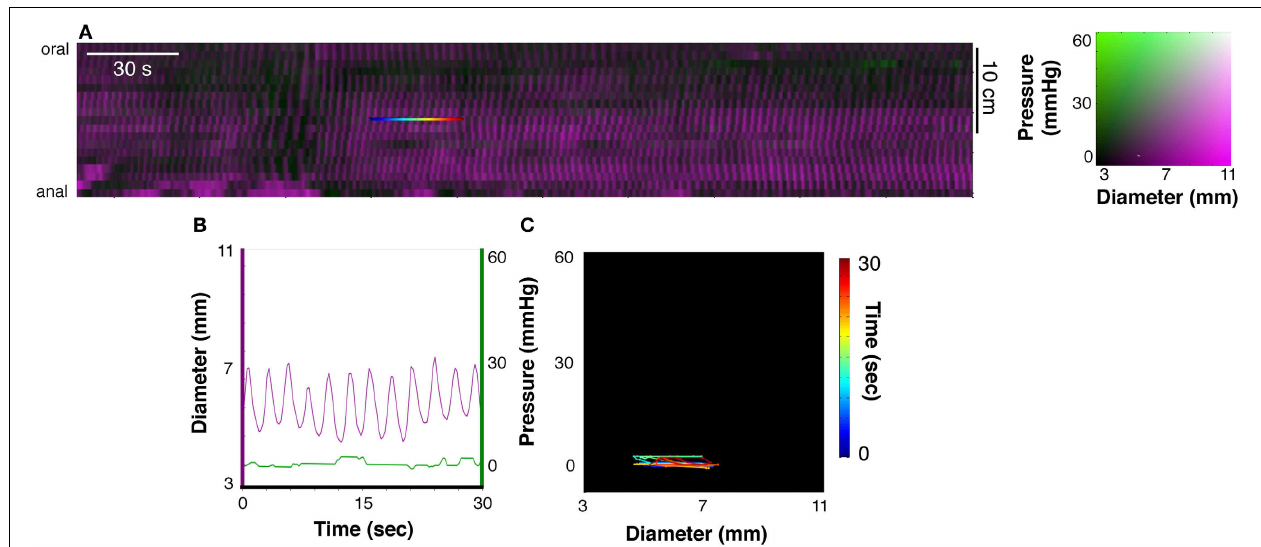
FIGURE 5 | (A) Shows a DPMap of the rabbit colon after the addition of TTX (0.6 µ M). All neurogenic activity is abolished, leaving only myogenic activity. Note that auto-scaling of the colors representing diameter (magenta) and pressure (green) exaggerate the amplitude of activity. Similar to Figure 2 , the line plots, pressure and diameter, in (B) and the orbit plot in (C) have been